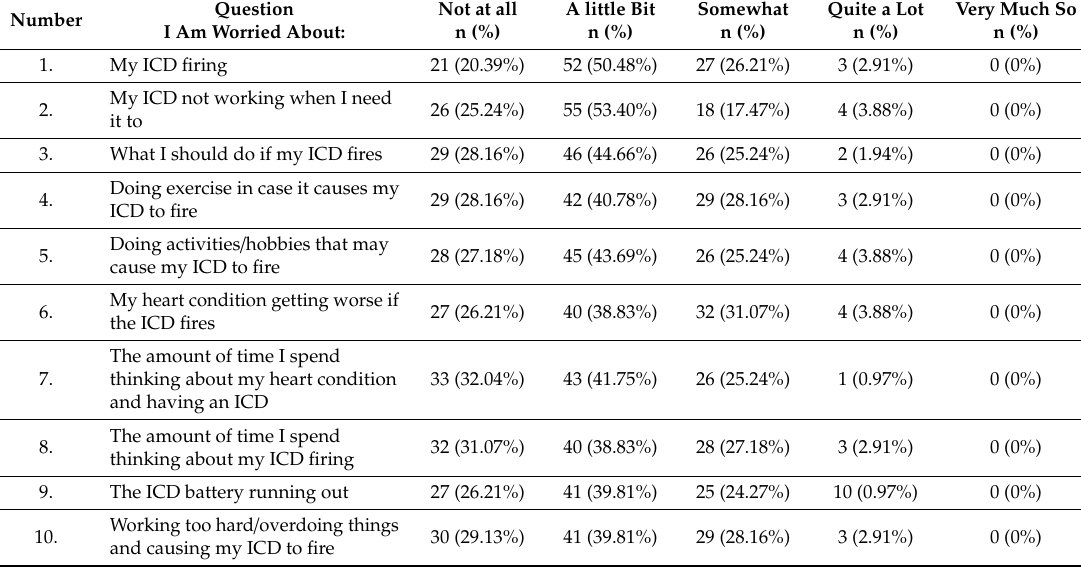
Table 2. Characteristics of the severity of the concerns about the implanted cardioverter